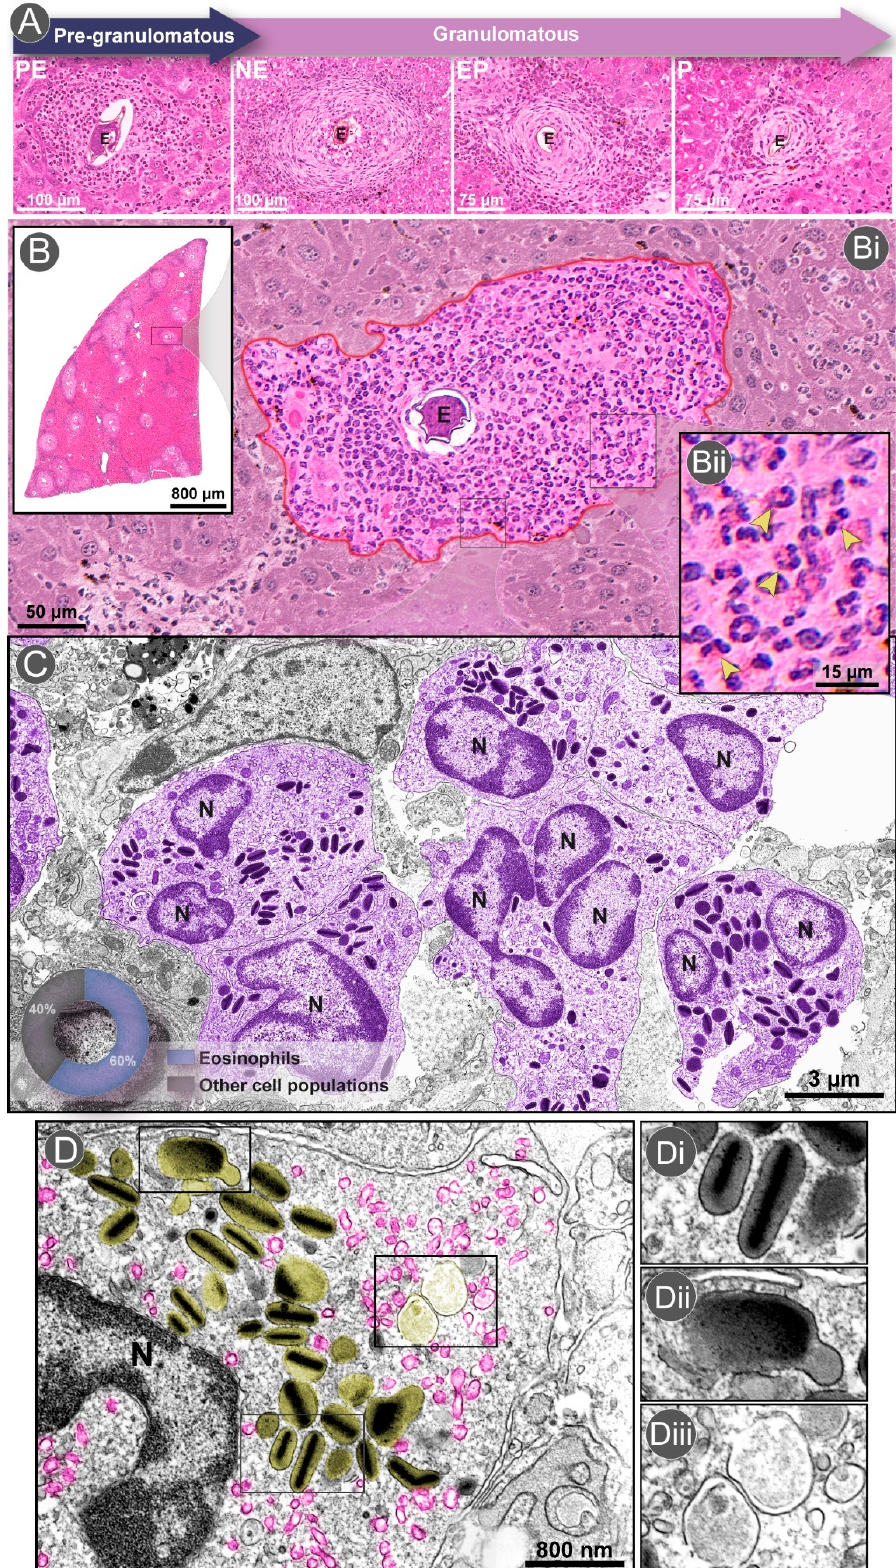
Figure 1. Eosinophils in a hepatic Schistosoma mansoni granuloma. ( A ) Evolutional stages of the hepatic granuloma and their features: Pre-granulomatous exudative (PE), with an initial infiltration of inflammatory cells in the organization process around the parasite egg (E); Necrotic-exudative